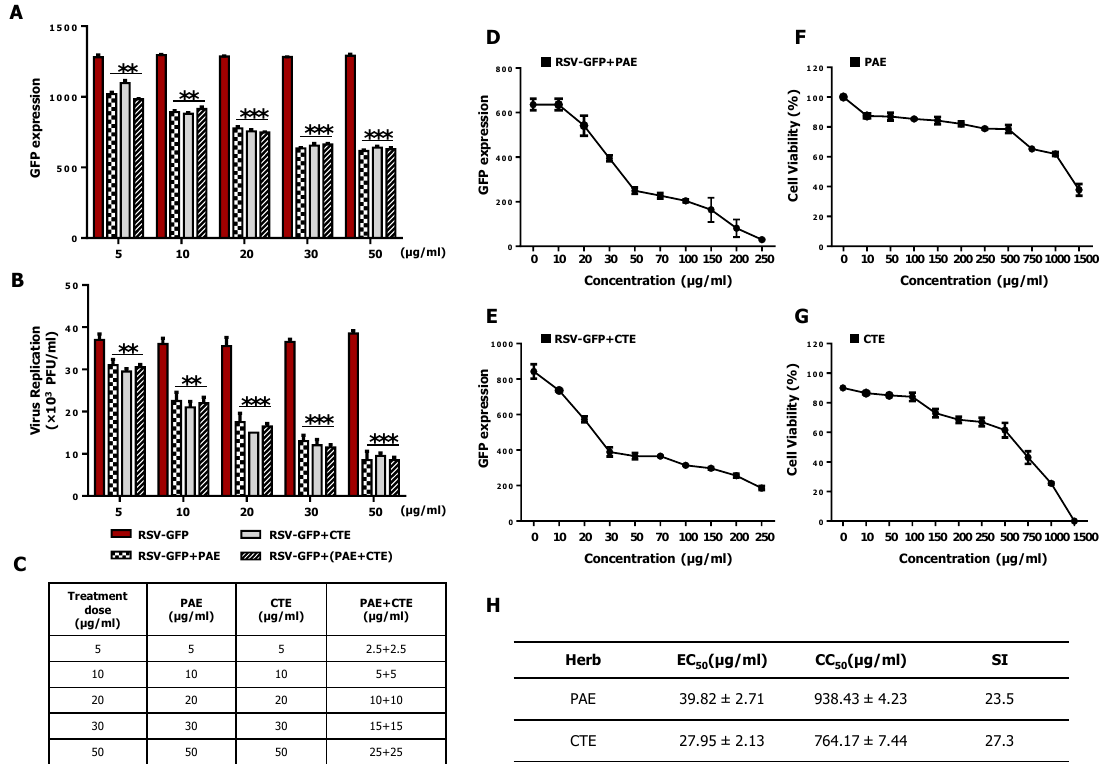
Figure 3. Synergistic e ff ect and e ff ective concentration (EC 50 ), cytotoxic concentration (CC 50 ) of PAE and CTE in HEp2 cells. ( A ) HEp2 cells were infected with RSV-GFP (0.1 MOI) for 2 h with DMEM containing 1% FBS. Cells were treated with PAE, CTE or combination of both at di ff erent concentrations with DMEM containing 10% FBS. At 48 hpi GFP expression level was determined. ( B ) Virus titer was measured from both supernatant and cells by standard plaque assay at 48 hpi and expressed as PFU. ( C ) Dose information of PAE and CTE single or combination treatment. ( D , E ) HEp2 cells were infected with RSV-GFP (O.1MOI) for 2 h with DMEM containing 1% FBS. Then, the medium was changed to DMEM containing 10% FBS and cells were treated with various concentrations of PAE ( D ) or CTE ( E ). 48 hpi GFP expression level was determined. ( F , G ) HEp2 cells were treated with various concentrations of PAE ( F ) or CTE ( G ), and cell viability was determined at 48 h post treatment (hpt) by cell cytotoxicity assay kit. ( H ) To calculate EC 50 value, 50% reduction of GFP expression was considered as equivalent to the 50% reduction in virus titer. The ratio between CC 50 and EC 50 was considered as Selectivity Index (SI). GFP absorbance and cell viability expressed as mean ± SD. Error bars indicate the range of values obtained from counting duplicate in three independent experiments. (** p < 0.01 and